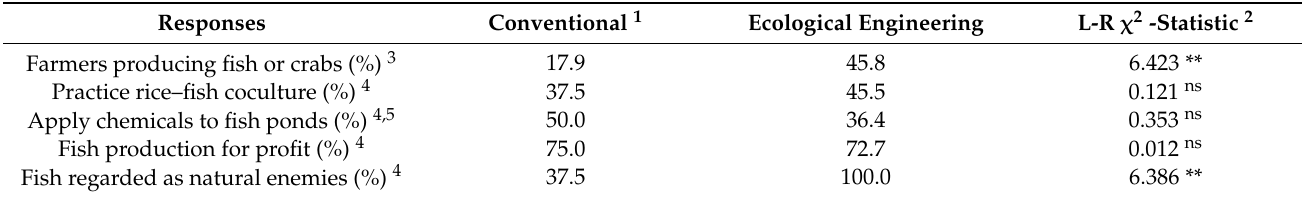
Table 3. Details of fish production in paddy landscapes at B ạ c Li ê u.